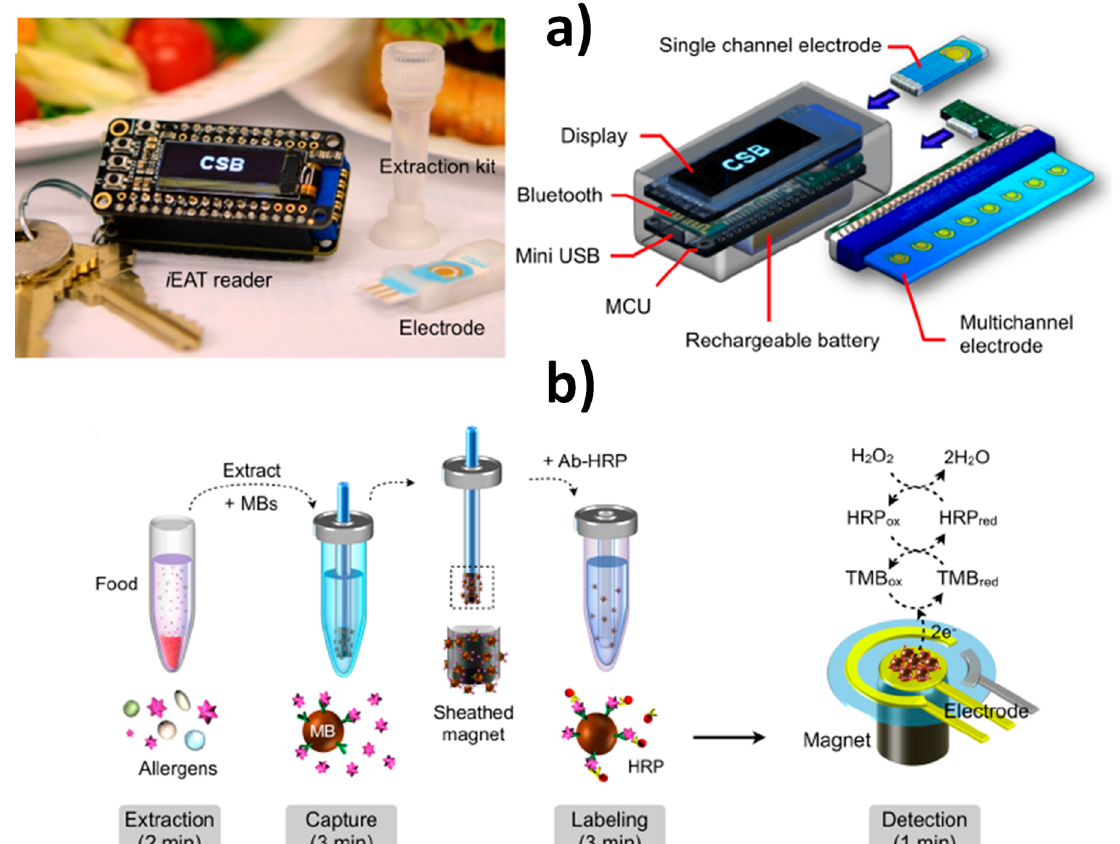
Figure 4. Integrated MBs-based immunosensing platform for on-site single or multiple food allergen detection. ( a ) iEAT system consisting of a pocket-size detector, an electrode chip, and a disposable kit for allergen extraction (left) and schematic of the pocket-size reader designed for standalone operation with its own display, rechargeable battery, and wireless communication module which allows to connect a single electrode or multiple electrodes through a card-edge connector. ( b ) Disposable kit to perform allergen extraction involving a sheathed magnet that collects the immuno-MBs. Once the MBs are modified with the HRP-labeled sandwich immunocomplexes they are dropped on the electrode and chronoamperometric transduction is performed in the presence of H 2 O 2 /TMB. Reprinted from [21], with permission.